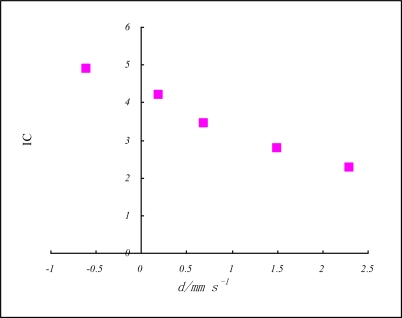
IC vs. δ for iron-57 as indicated in Table 9.